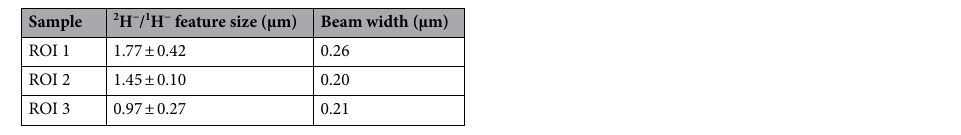
Table 1. Table of 2 H − / 1 H − feature sizes and NanoSIMS beam widths for ROIs in Fig. 1.